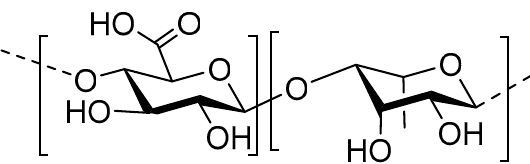
Figure 7. Structure of the main components of POS; a non-methylated d –galacturonic acid monomer ( left ) linked in a β 1 → 4 fashion with a rhamnose monomer ( right ).